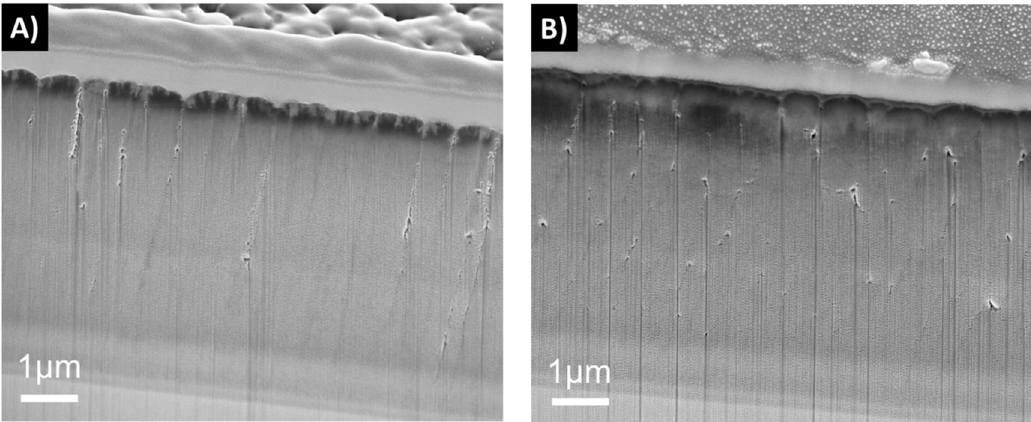
Figure 7. Cross sections from sample 3D-3f-H3-P3.4-C before ( a ) and after the ( b ) reciprocal wear test, showing surface morphology and coating layer cross sections.